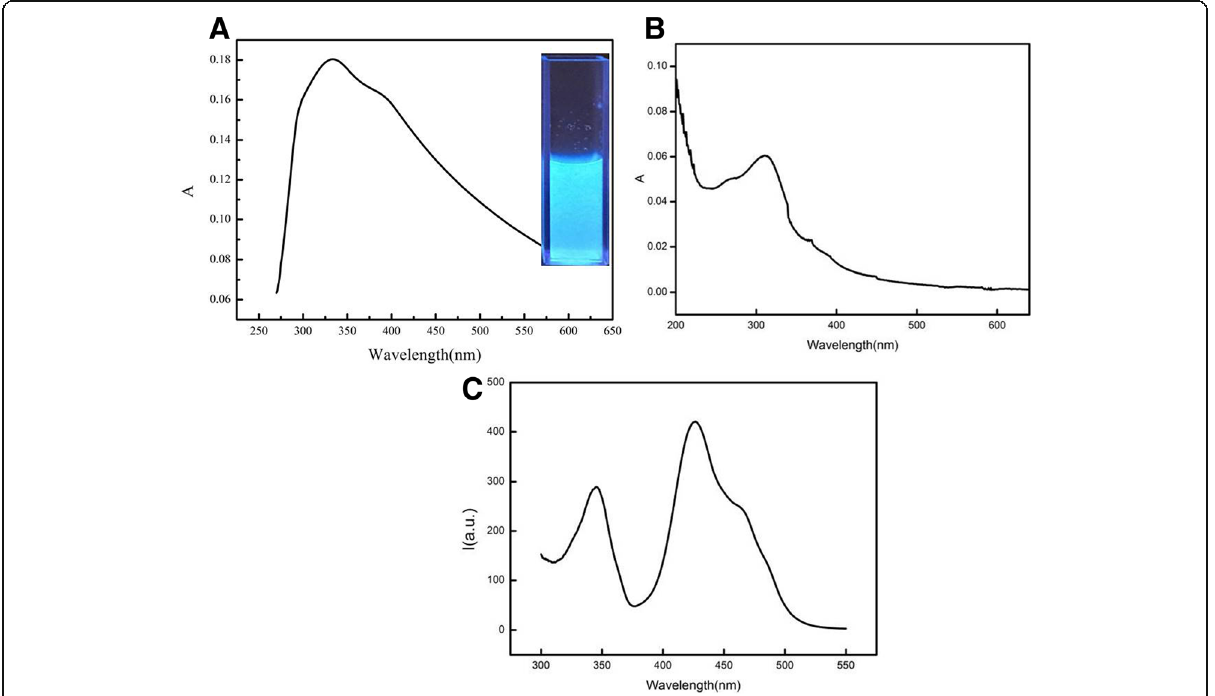
Fig. 3 The UV-vis absorption and fluorescence spectrum of CdSe QDs/g-C 3 N 4 conjugates